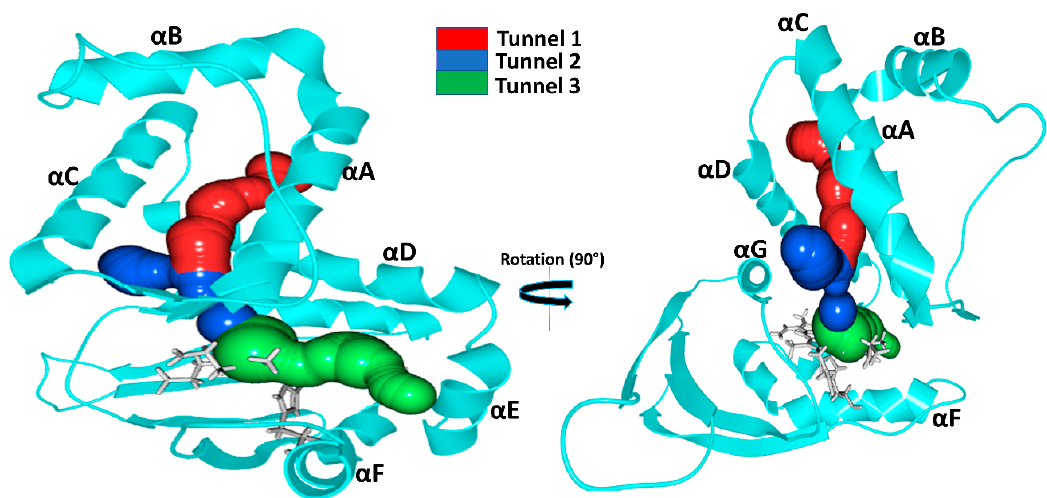
Figure 4. Identified gas migration tunnels. As the three-dimensional structures of the three proteins are very similar only the structure of Ns H-NOX is shown. The long, apolar tunnel is shown in red, while the shorter Tunnels 2 and 3 are shown in blue and green, respectively. The heme group and the proximal histidine residue are shown in gray.